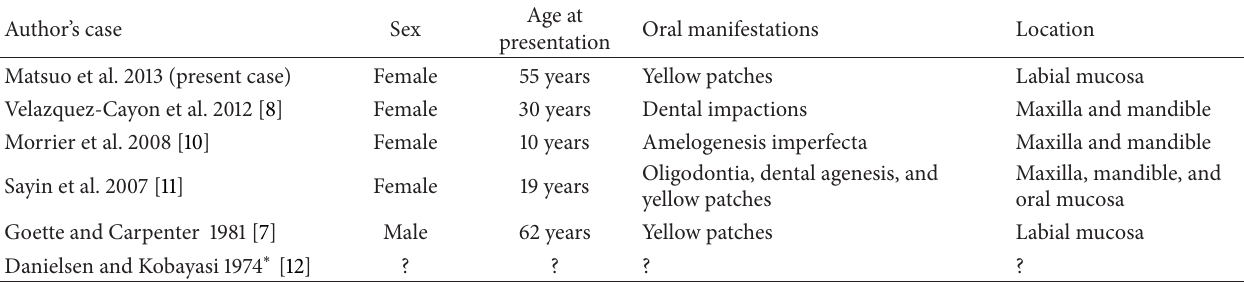
Table 1: Case reports of PXE with oral